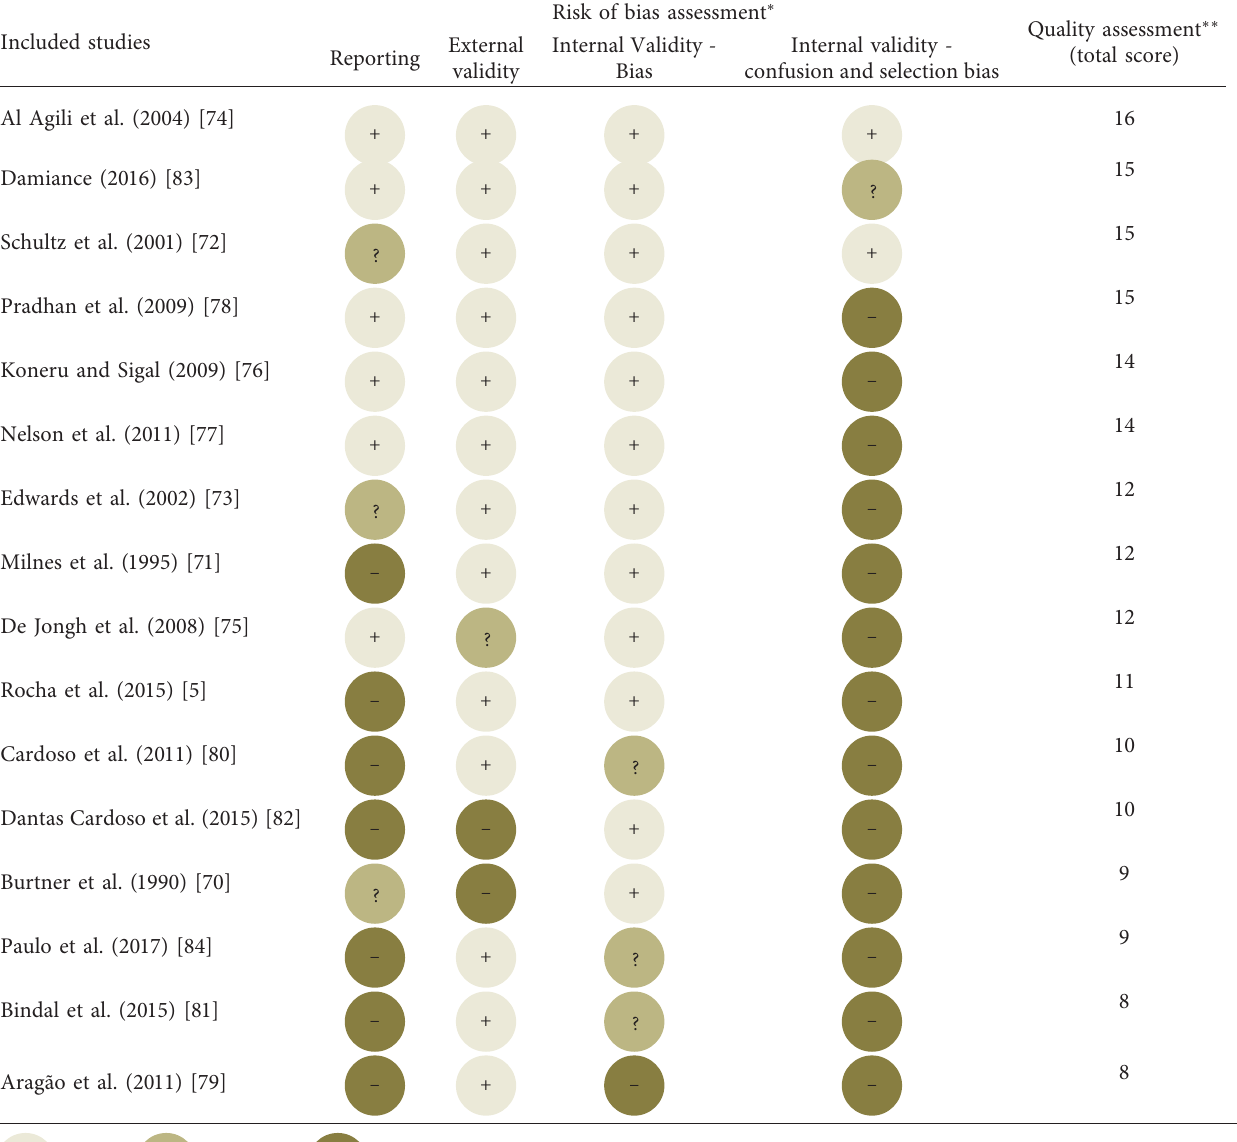
Table 3: Summary of the quality and risk of bias